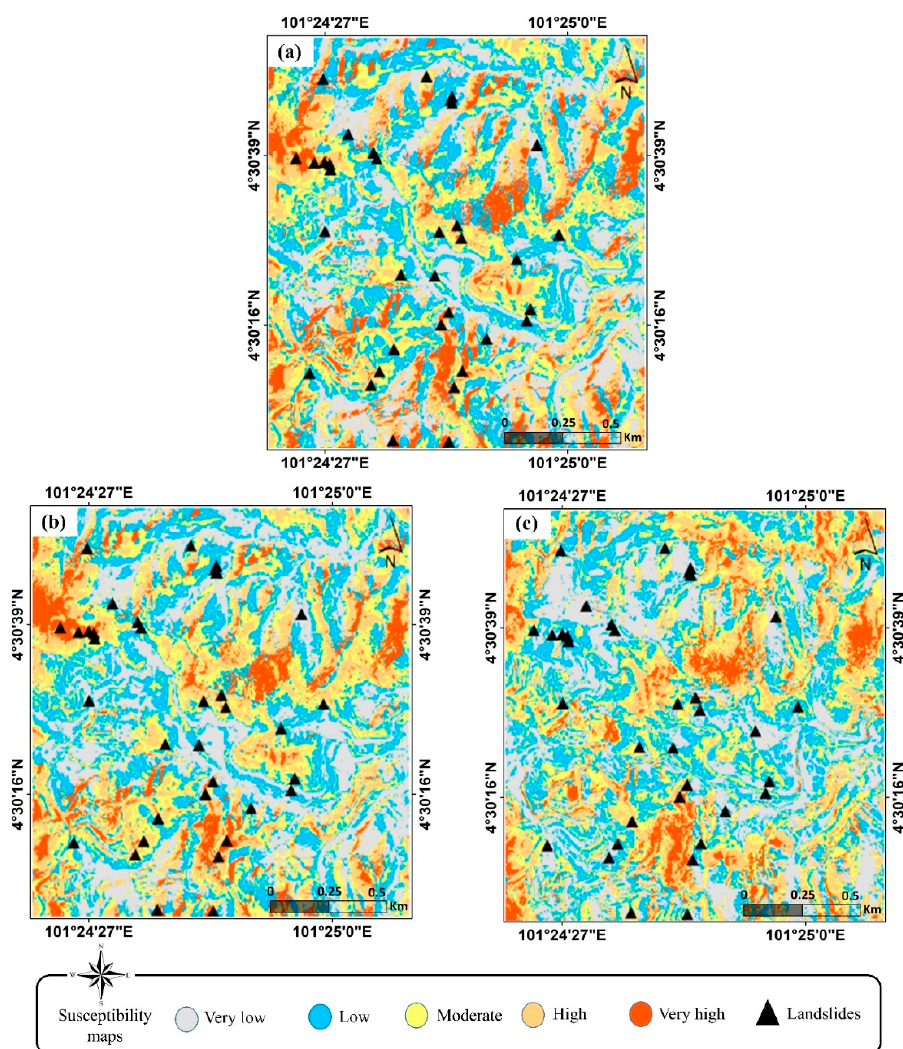
Figure 6. Landslide susceptibility maps: ( a ) XGB using Std-X; ( b ) LR using Power-X, and ( c ) ANN using Ohe-X.